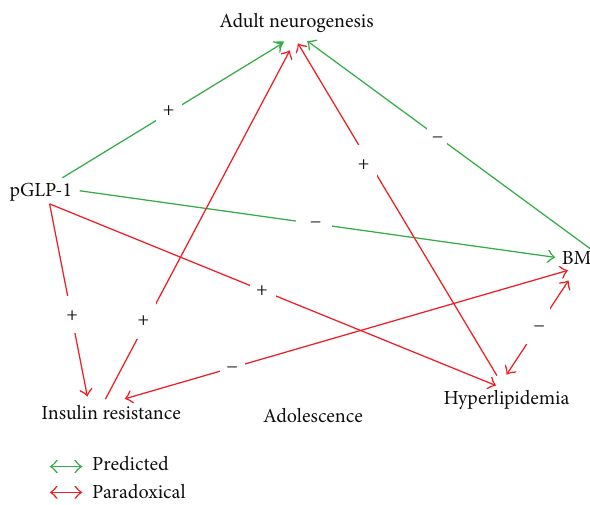
Figure 5: Schema of predicted and paradoxical associations of adolescent metabolic markers in the prediction of adult neuroge- nesis. Green lines indicate correlations that are observed to occur in the predicted direction whereas red lines are predictions that are observed to be opposite to the predicted direction. The significant Kendall coefficient of concordance for multiple dependent variables determined by the Friedman ANOVA (see text under results) raises the possibility of a complex, ostensibly paradoxical physiological metabolic pattern, which sets the stage for future neurogenesis, whereby glucose and lipids provide vital metabolic substrates in the maintenance of the relatively high levels of neurogenesis observed in relatively low BMI